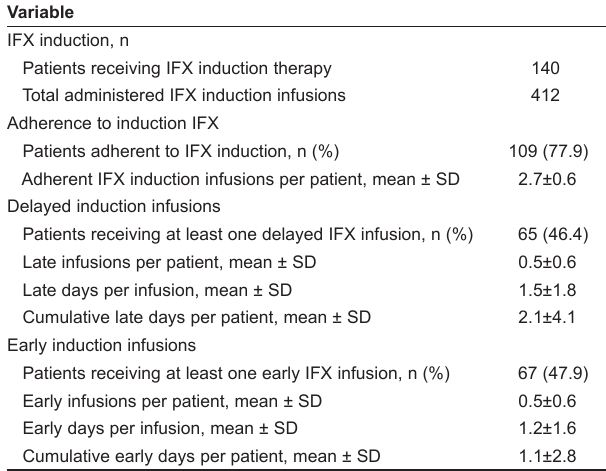
Table 2 Patient adherence* to infliximab (IFX) induction therapy